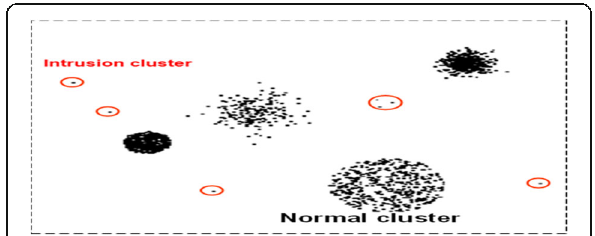
Fig. 7 Using Clustering for Intrusion